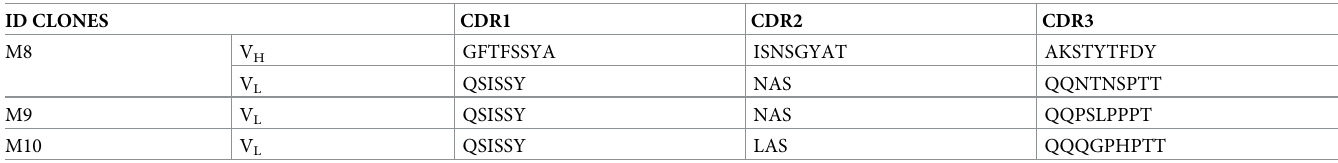
Table 2. CDRs sequences of each single domain of the three